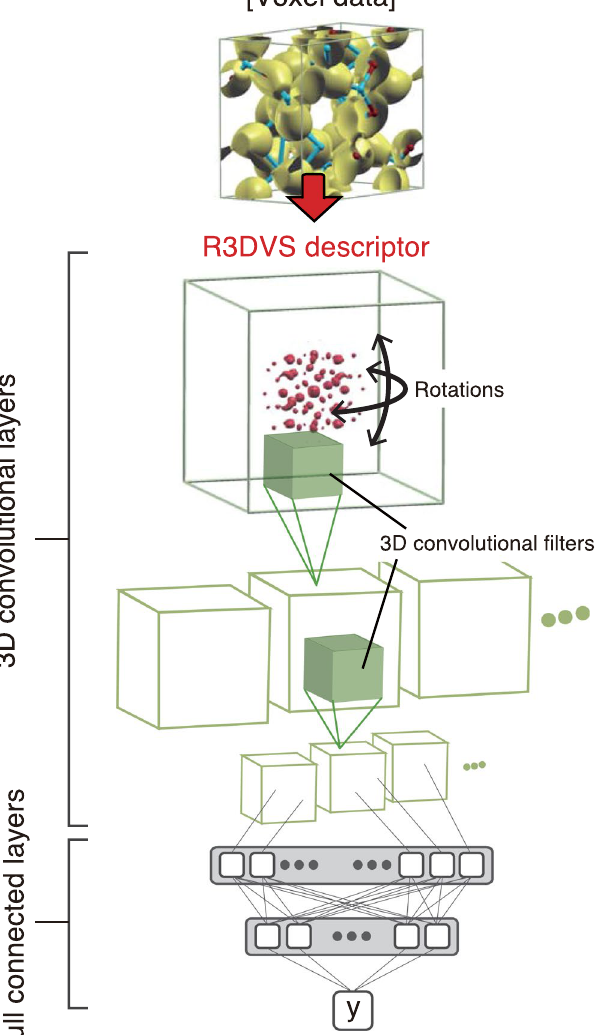
Figure 2. An illustration of the three-dimensional CNNs with the R3DVS descriptors. The letter “y” stands for an objective